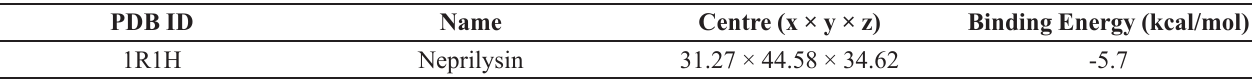
TABLE III - Binding site coordinates for the pose with the lowest binding